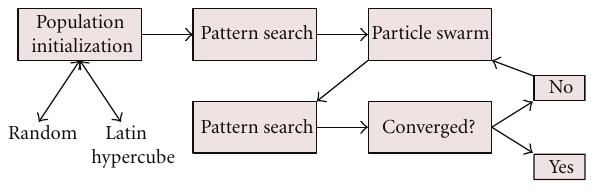
Figure 4: Hybrid optimizer flow